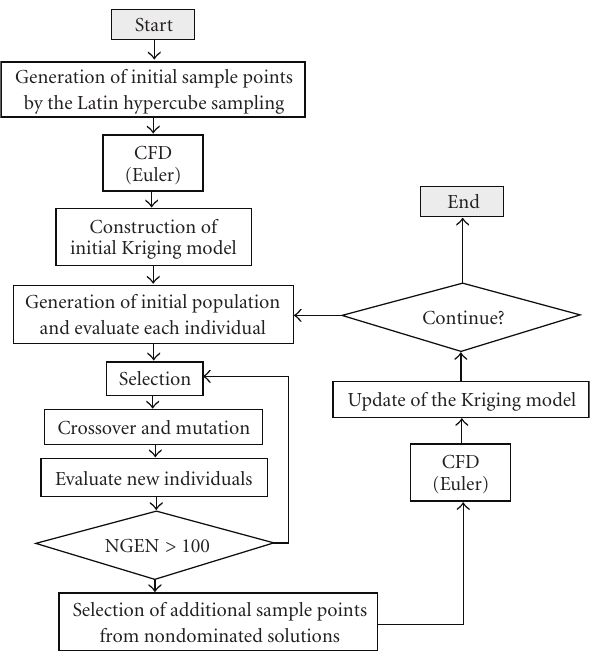
Figure 1: Flowchart of aerodynamic design system.